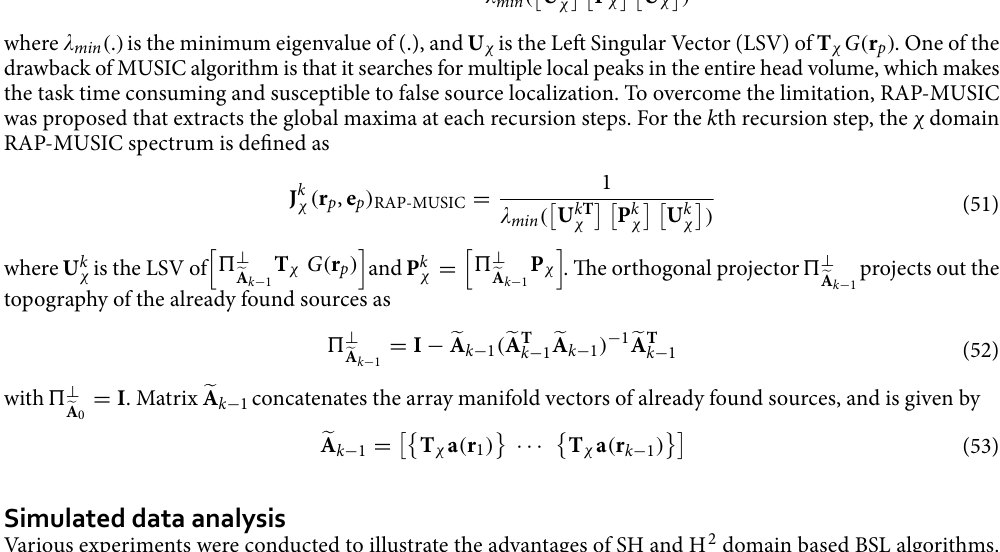
Figure 3. 3D view of ( a ) spatial MUSIC, ( b ) SH MUSIC and ( c ) H